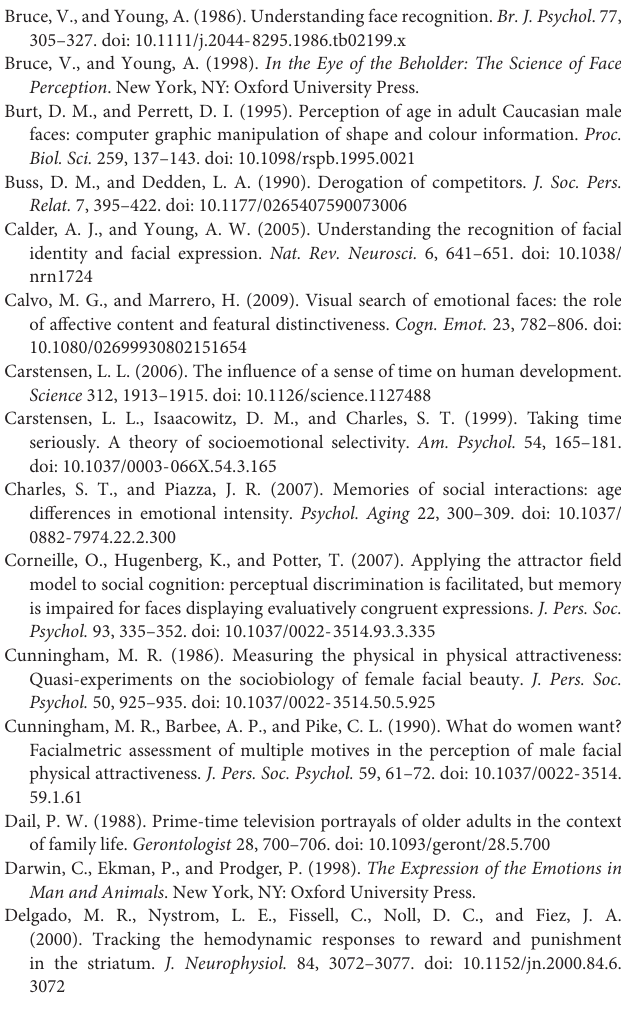
DATA SHEET 1 | Perceived facial attractiveness. DATA SHEET 2 | Perceived facial